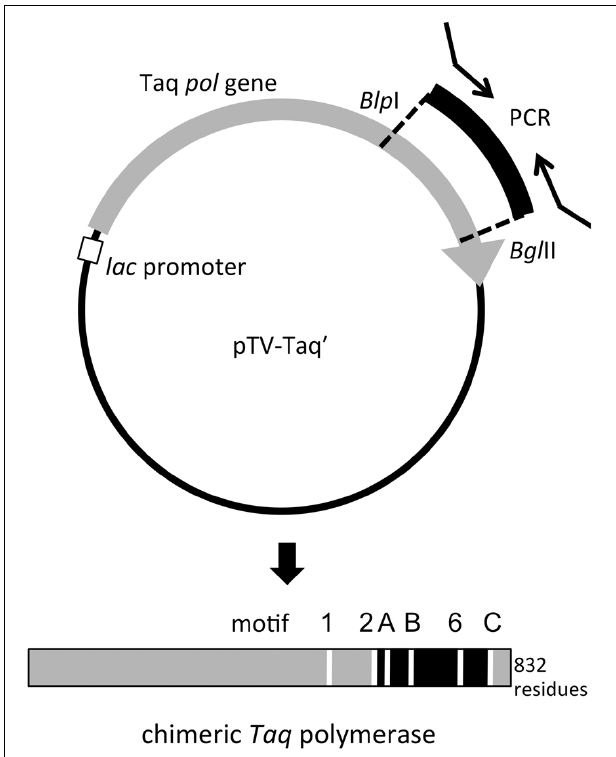
FIGURE 2 | Schematic diagram of the construction of the expression plasmid for chimeric Taq polymerase. The recognition sites for BlpI (GCTNAGC) and BglII (AGATCT) were created in the Taq pol structural gene (gray arrow). The introduced gene fragments (black) also have the recognition sequences for these two enzymes from the PCR primers, and the substitution of the DNA fragments can be performed directly on this plasmid (upper panel). The produced chimeric protein is shown by a bar (lower panel). The replaced region was indicated in black. The motifs conserved in family A DNA polymerases are indicated by white lines (Loh and Loeb, 2005).